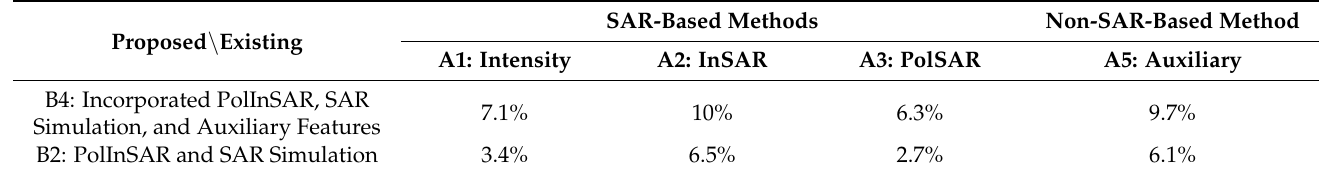
Table 9 . Highest classification accuracies achieved in B category .